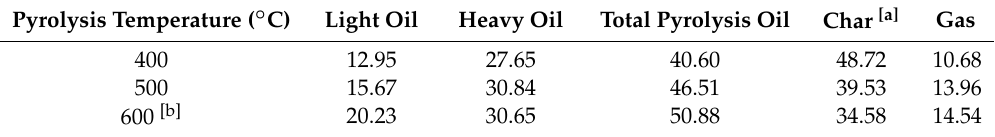
Table 3. Yields of light oil, heavy oil, char, and gas for the pyrolysis of bark at 400, 500, and 600 ◦ C. Pyrolysis Temperature ( ◦ C)